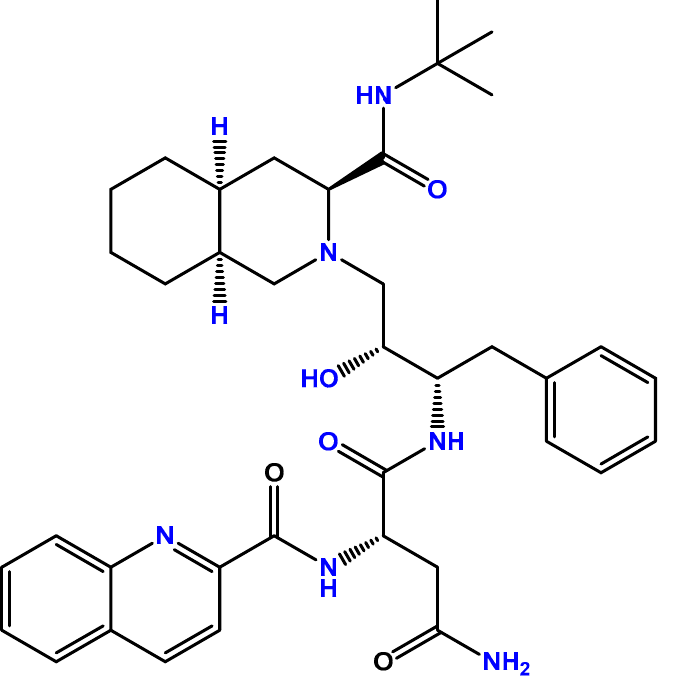
Figure 1. Chemical structure of saquinavir (developed with ChemDraw ® , a chemical drawing soft- ware, https://chemdrawdirect.perkinelmer.cloud/js/sample/index.html, accessed on 5 June 2022).